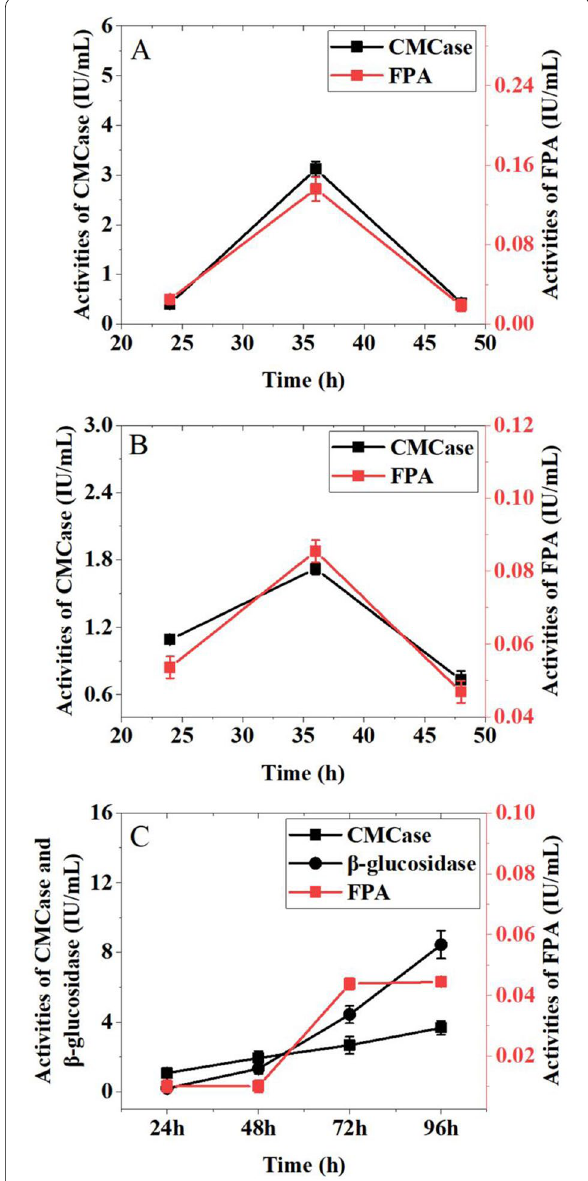
Fig. 4 Effects of incubation time on cellulases production by T.